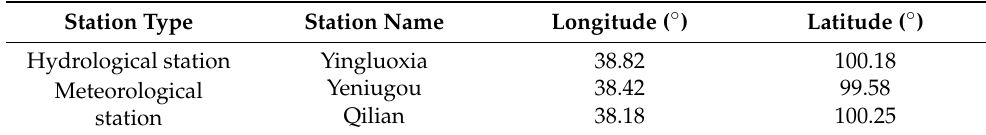
Table 2. Locations of meteorological and hydrological stations in the study